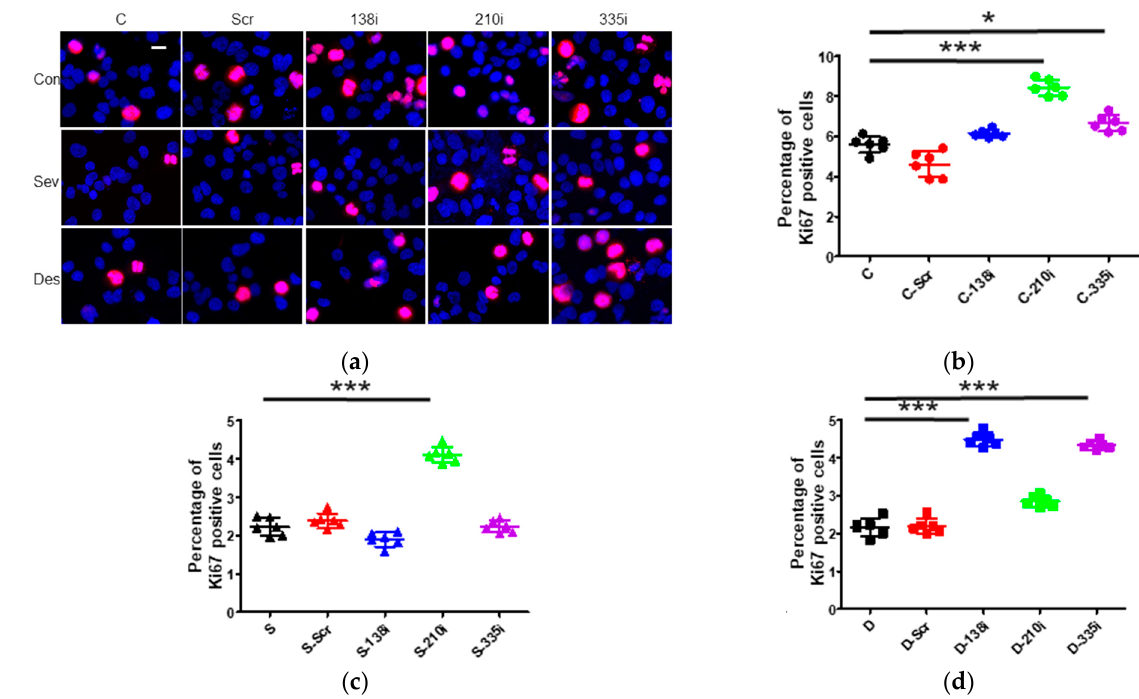
Figure 3. The changes of cell proliferation after 2 h of inhalational anesthesia with miRNA inhibitor pretreatment. ( a ) Neuroglioma (H4) cell proliferation analysis with Ki67 immunofluorescence staining: Ki67 (red), marker for cell proliferation, in control (upper), sevoflurane- (middle) and desflurane-treated (bottom) H4 cells, counter-stained with DAPI (blue); × 20 magnification, scale bar = 20 µ m. ( b – d ) Cell proliferation analysis with Ki67 immunofluorescence staining with anesthesia and miRNA inhibitor pretreatment relative to each control group at 24 h after exposure: ( b ) control anesthe- sia, ( c ) 3.6% sevoflurane anesthesia and ( d ) 10.4% desflurane anesthesia. Data showed as plots and mean ± SD (n = 6). * p < 0.05, *** p < 0.001; One-way ANOVA with Tukey-Kramer compared to each control group. C: control, S: sevoflurane, D: desflurane, Scr: scrambled miRNA, 138i: miR-138 inhibitor, 210i: miR-210 inhibitor and 335i: miR-335 inhibitor.